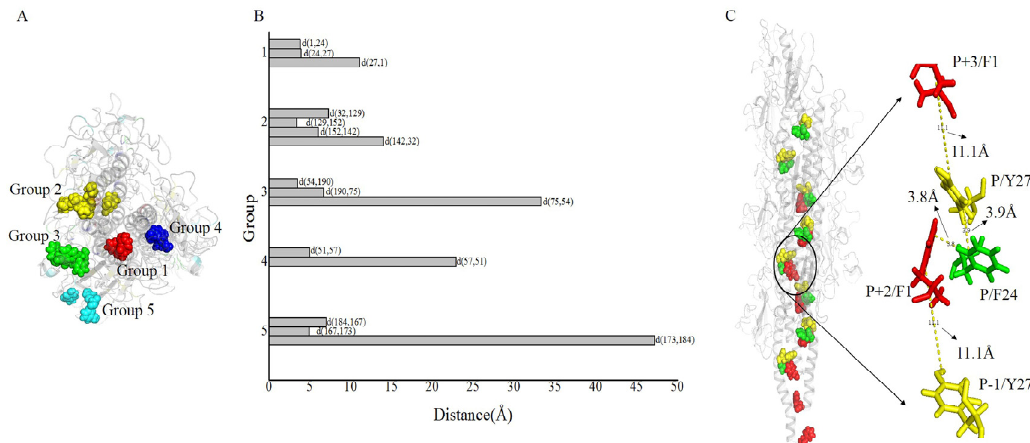
Figure 5. Details of the structure for G. uraniireducens pilus. The pilus structure is represented schematically in transparent gray. ( A ) Aromatic amino acids in different groups are highlighted by different colors. Red, yellow, green, blue, and cyan sticks are used to represent aromatic amino acids in Groups 1–5, respectively. ( B ) In different groups, the distances between proximal carbon atoms of aromatic rings are measured. ( C ) The tentative helical pathway for electron transfer in the pilus is represented. Red, green, and yellow spheres highlight the positions of F1, F24, and Y27, respectively. The distances between proximal carbon atoms in neighboring aromatic rings are indicated.